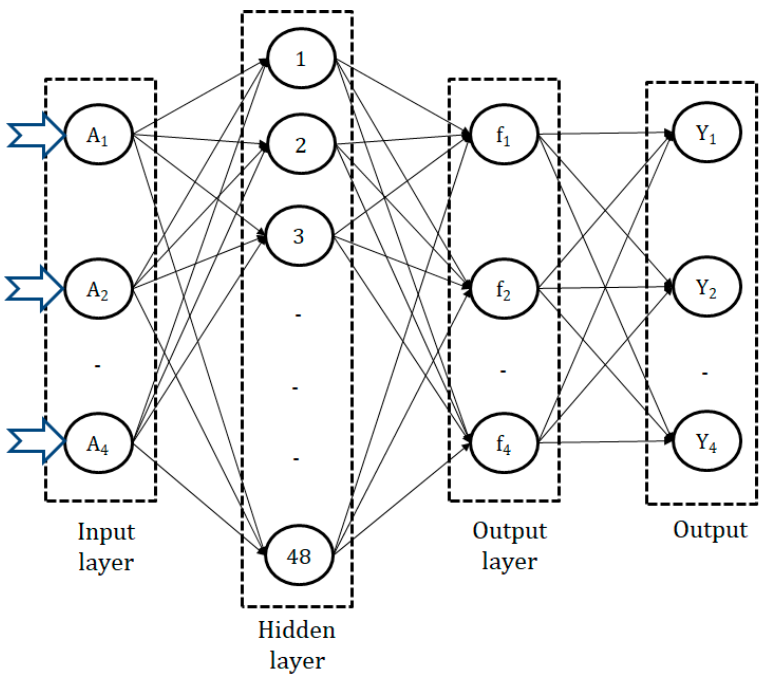
Figure 3. Architecture of the BPNN.